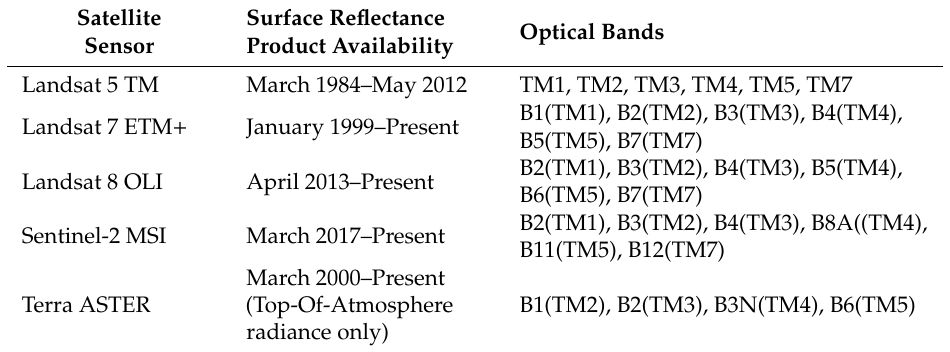
Table 1. List of major multispectral satellite data assets on GEE and their band signations compatible with Thematic Mapper